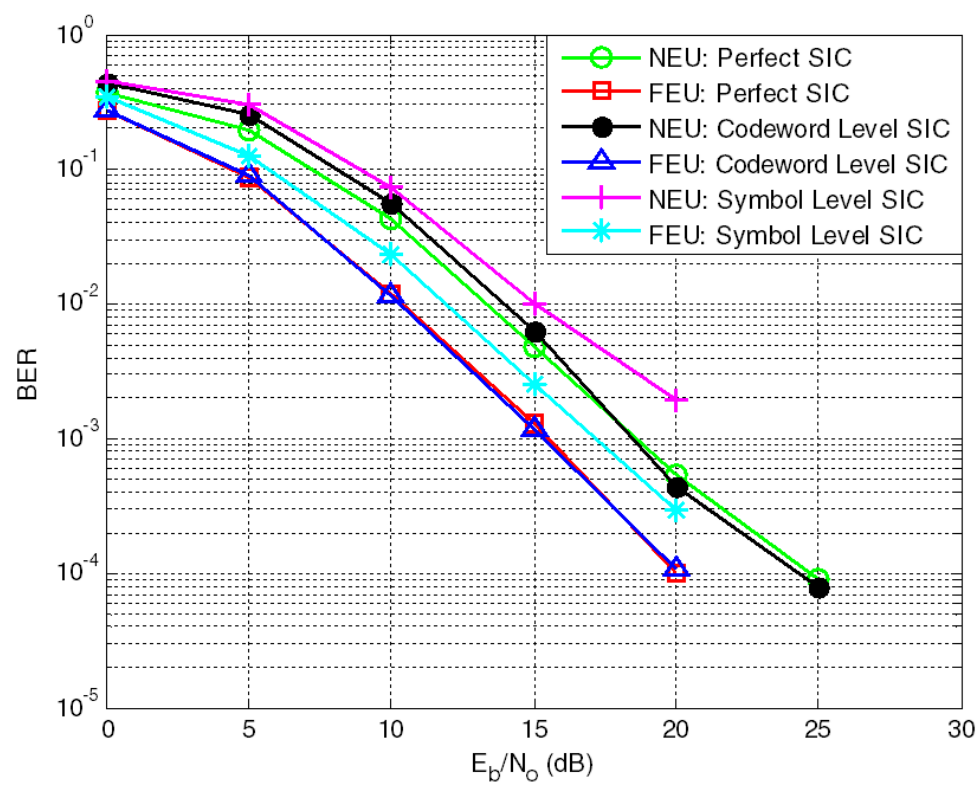
Figure 8. BER performance comparison of different receivers for NEU and FEU with P 1 , P 2 =